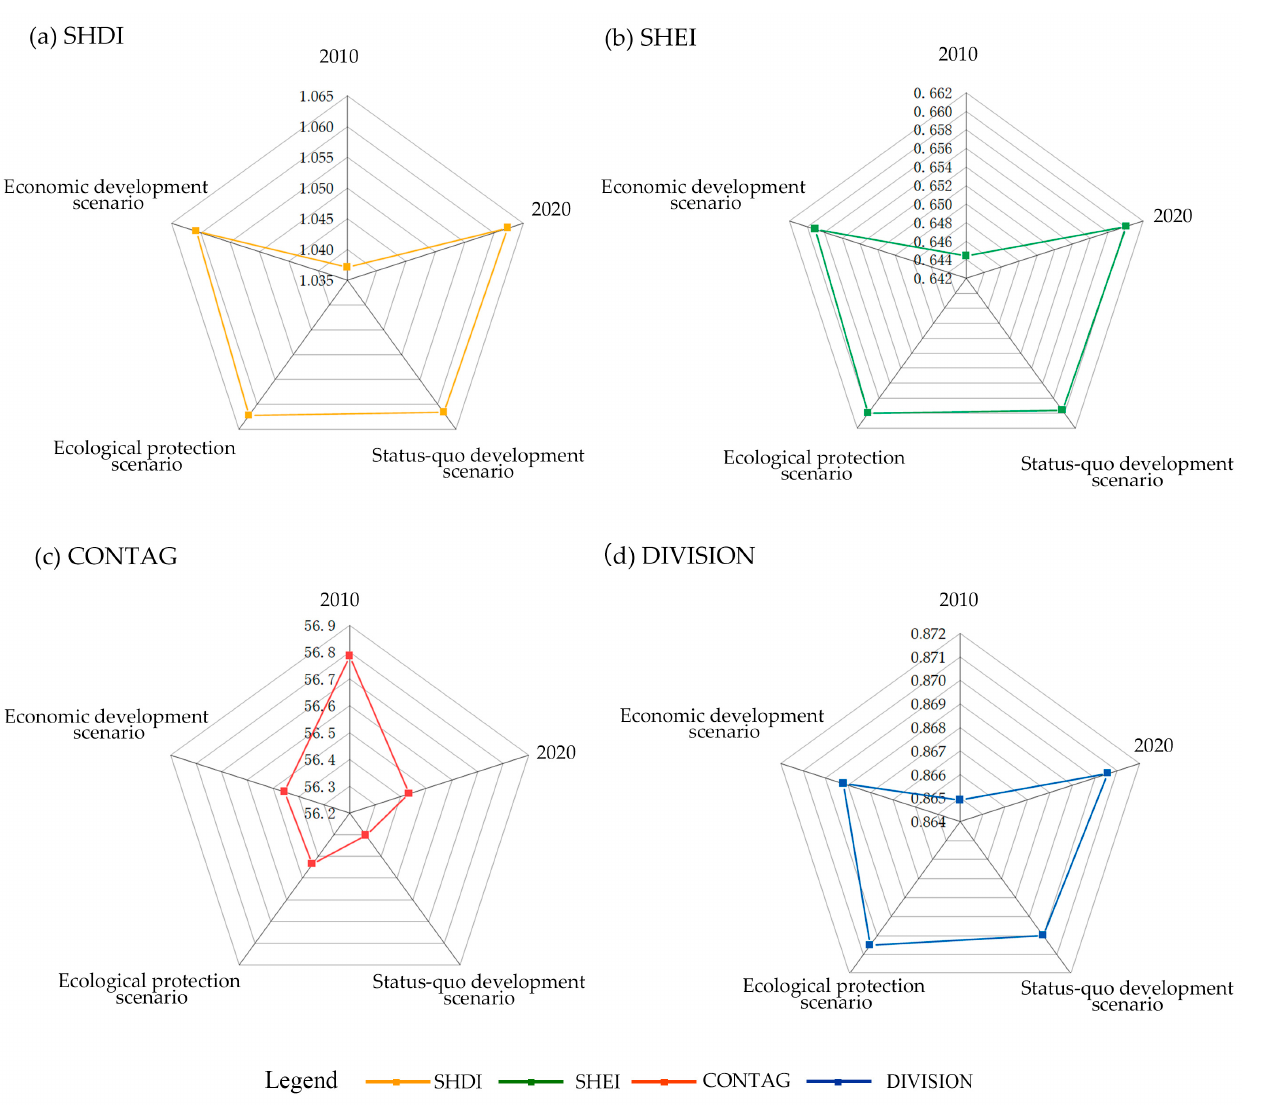
Figure 9. Landscape-level landscape indices in the study region. Table 5. Landscape-level indices.